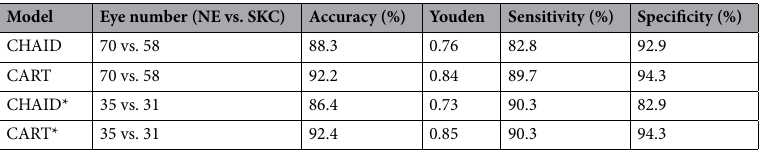
Table 1. The performance of CHAID and CART models to discriminate SKC from NE. CHAID, CHAID model based on training-database; CHAID, CART model based on training-database; CHAID*, the validation of CHAID; CART*, the validation of